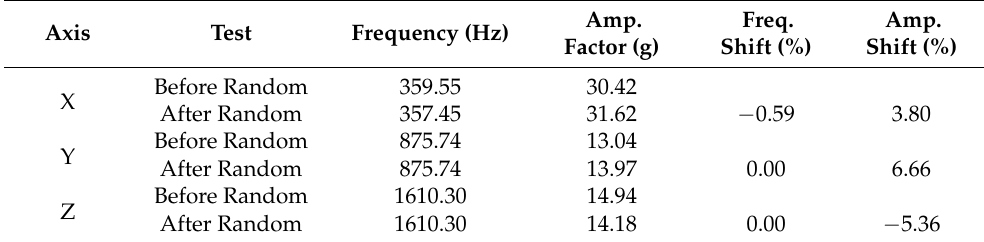
Table 8. Low-level sine sweep test results before and after random vibration.